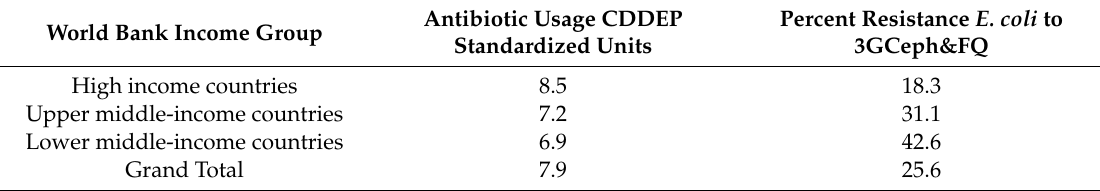
Table 1. Income e ff ects: antibiotic usage and antimicrobial resistance Table 1. Income effects: antibiotic usage and antimicrobial resistance levels.